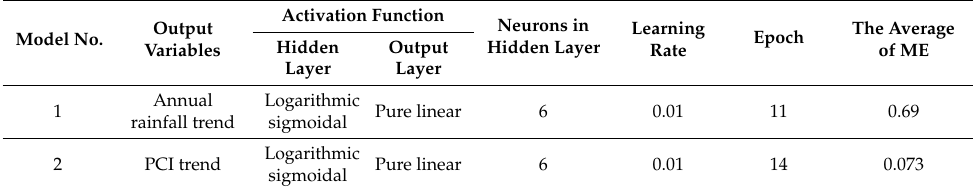
Table 3. Properties of the developed neural networks and errors obtained from cross-validation of each model.